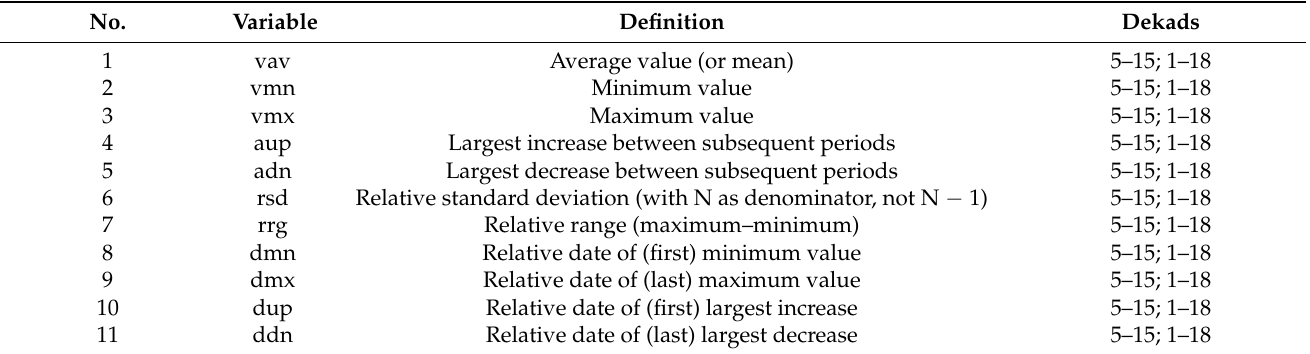
Table 2. The 11 phenological variables derived from FAPAR, LAI, and NDVI time series (extracted using the time statistics function of SPIRITS [44] for 2 periods: dekads 5 to 15 and dekads 1 to 18, from 2000 to